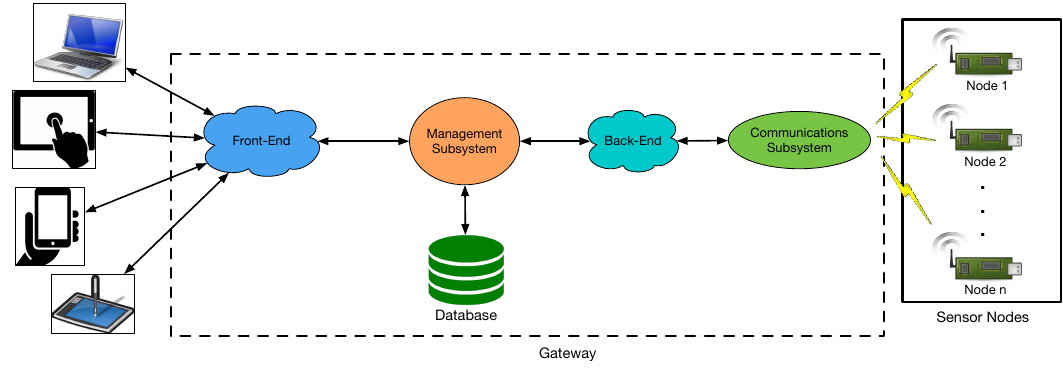
Figure 2. Global overview of the